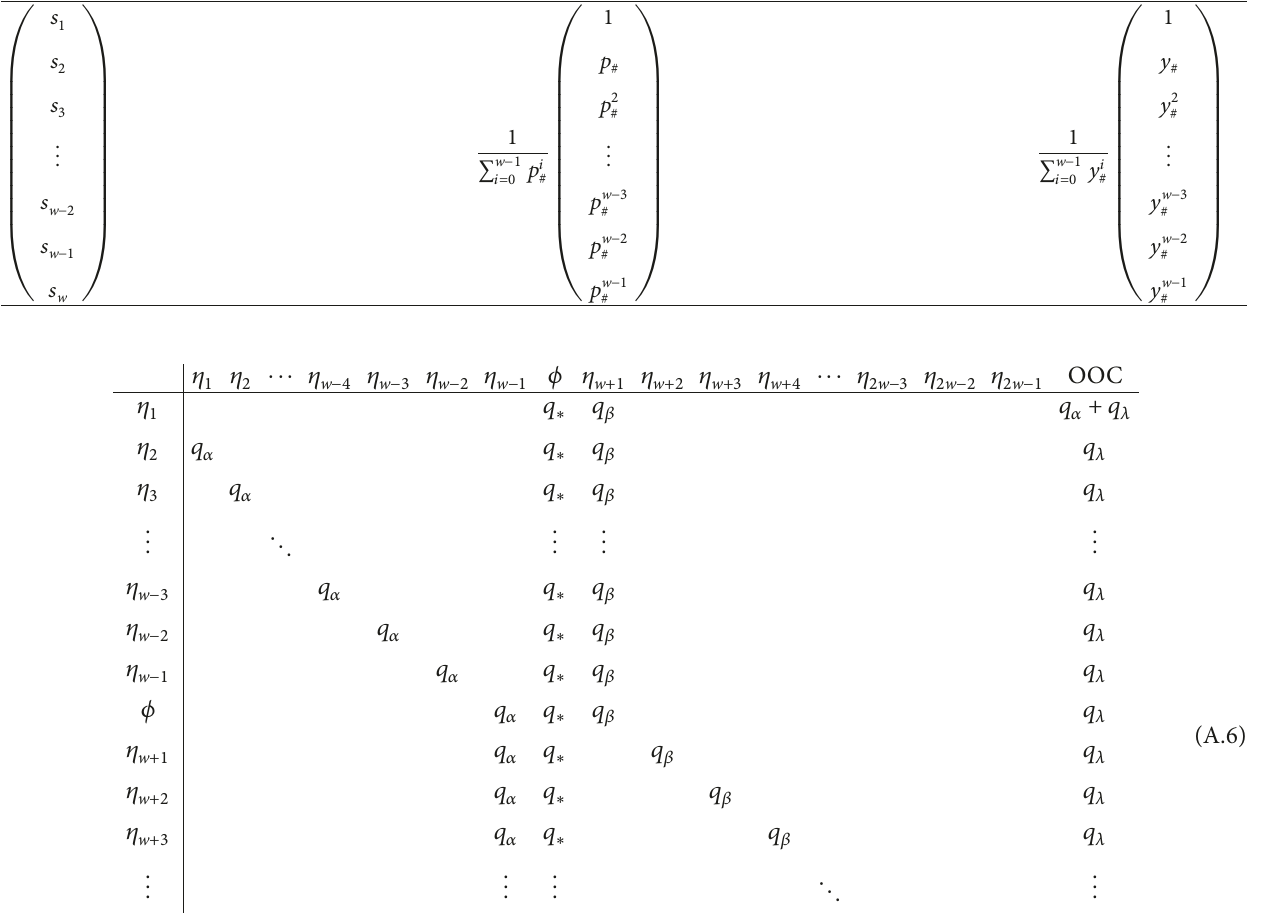
Table 9: The steady-state initial probability vectors of the one-sided and two-sided NSS w-of-w SRR and IRR schemes.